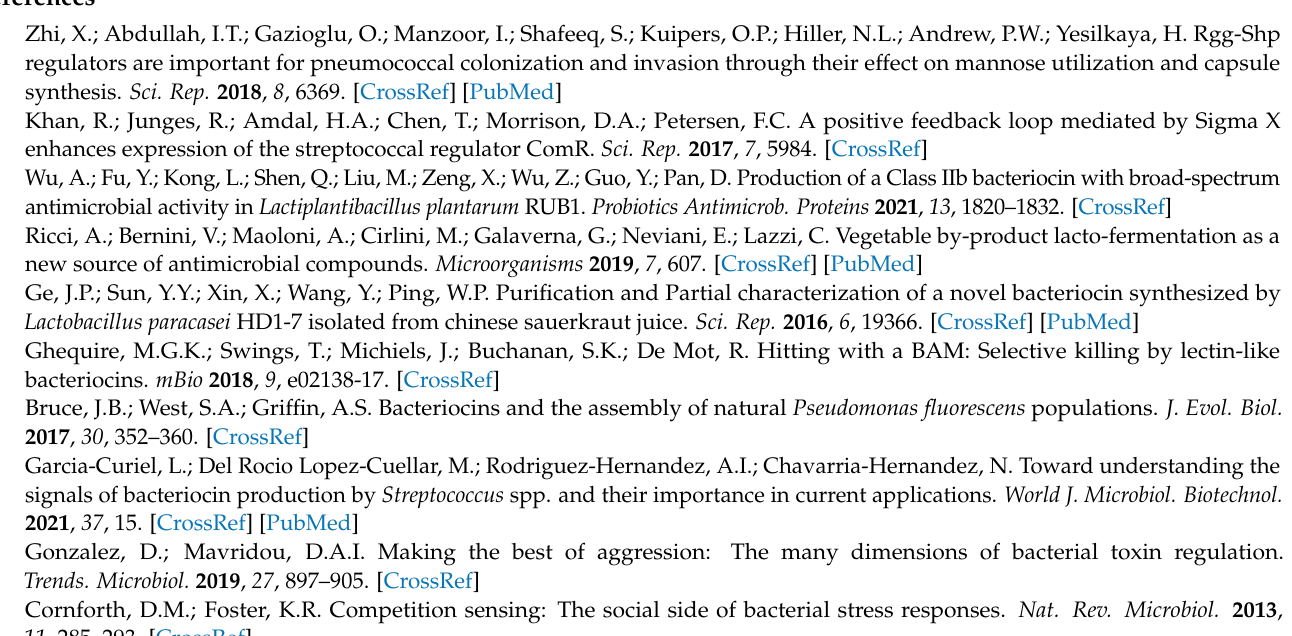
Figure S7: Effects of acetic acid and lactic acid stress on the growth and metabolism of L. paracasei HD1.7; Table S1: Primers sequences for qRT-PCR; Table S2: Differences between metabolites in CFS12 and CFS60; Table S3: Effects of CFS-B on the growth of L. paracasei